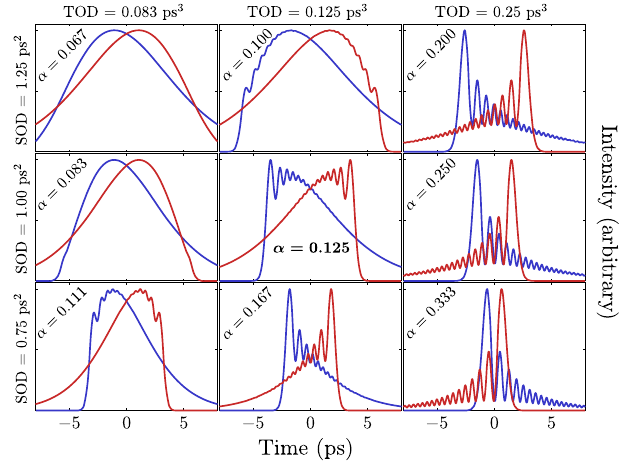
FIG. 2. Pulseenvelopes resulting fromdifferent combinationsof SODandTOD.Each columnhas athesame magnitude oftheTOD value at the top and each row has the same magnitude of SOD. The blueplotresultsfromcombinationswithnegativeSODandpositive TOD while the red plot is positive SOD and negative